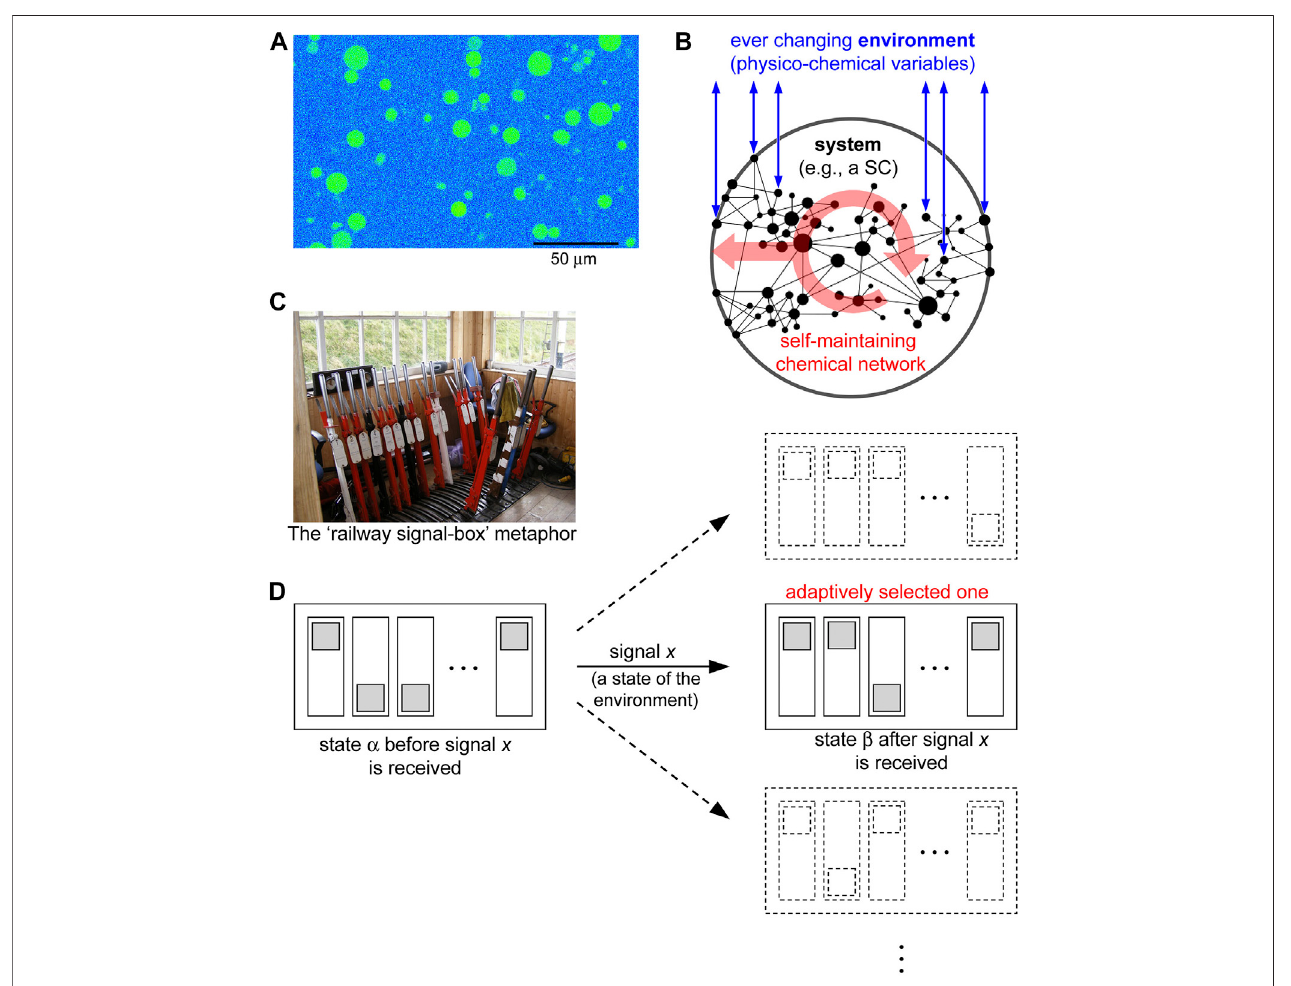
FIGURE1| Syntheticcells(SCs)andsemanticinformation. (A) Confocal fl uorescenceimageofSCsproducinga fl uorescentprotein.Sizebarmeasures50 μ m. (B) SCs can be considered as chemical systems, whose dynamics is determined by an internal chemical network, surrounded by an ever changing (physico-chemical) environment. Complex SCs function thanks to a self-maintaining network, which is perturbed by the variations of the environmental variables (e.g., by the presence of chemicalswhichdirectlyinteractwiththenetwork,affectingitsdynamics).Theredarrowsinsidethesystemrepresenttheself-productionofcomponents,included the ones which constitute the boundary. (C) MacKay used the “ railway signal-box ” metaphor for the changes that messages cause to the organization states of a receiver system, which he called “ states of conditional readiness ” (image in the public domain, https://www.publicdomainpictures.net/en/view-image.php? image (cid:1) 2462&picture (cid:1) signal-box). (D) Accordingtothe “ railwaysignal-box ” metaphor,itispossibletodrawaveryschematicrepresentationoftheselectingroleasignal x exertsonthestatesofareceiversystem,hereindicatedbyatransitionbetweenthestates α and β .Thesystemsstates,forsimplicity,havebeenrepresentedbyanarray of binary system ’ s variables. In the case of biological cells, such a transition rule ( α to β caused by x ) was evolutionary “ assigned ” to the signal x adaptively, aiming at increasing the system fi tness (e.g., the cell viability in the environmental conditions represented by the signal x ), and it clearly depends on the initial state too.